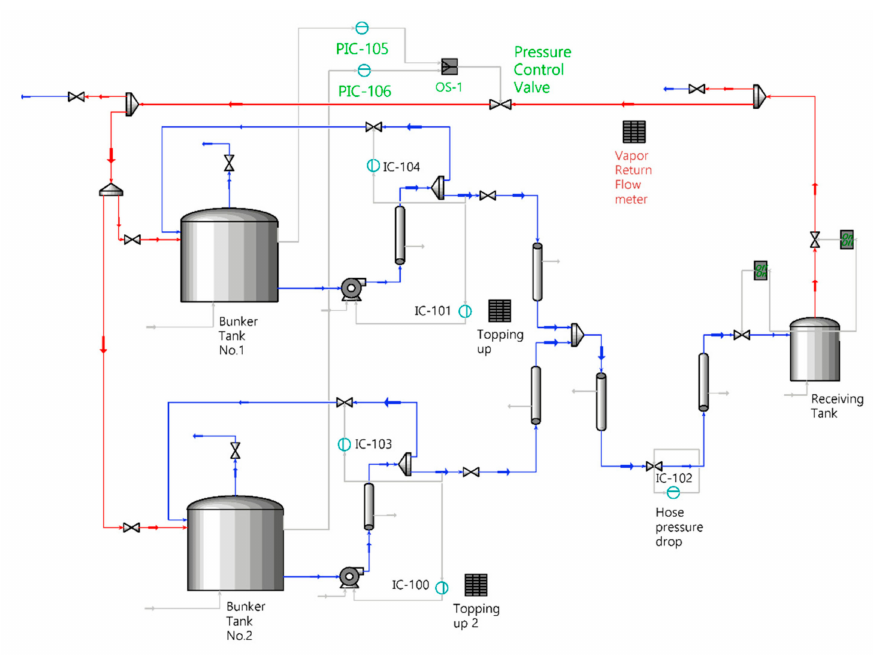
Figure 10. Dynamic process modeling with bunker tank pressure